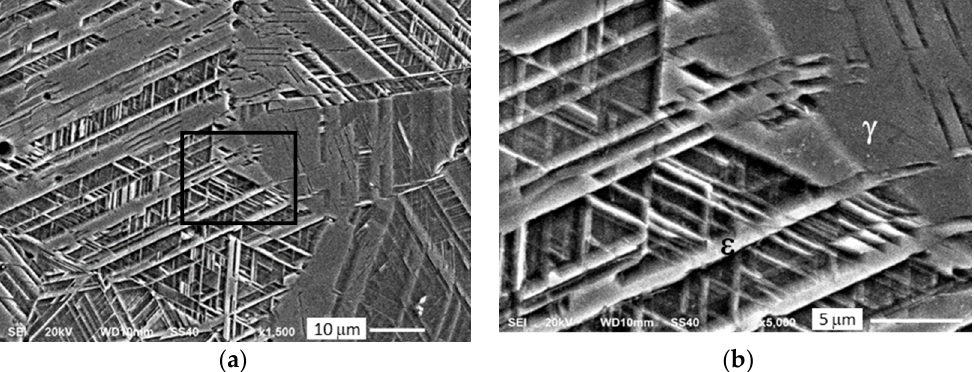
Figure 2. SEM micrograph showing a general view of the SMS alloy ( a ) and the enlarged area labeled with a black square in Figure 2a ( b ).